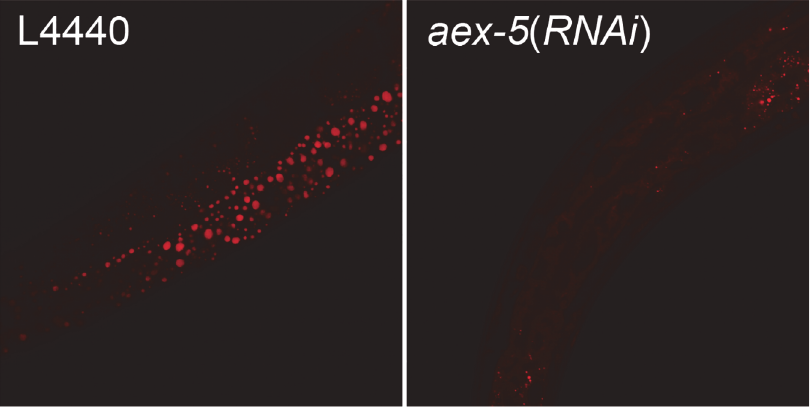
Fig 4. Fluorescence confocal micrographs of the intestines of young adult worms stained with Nile Red in isopropanol. The worms were subjected to RNAi by feeding after they had become adults. L4440 is the negative control in which wild-type adult worms were fed bacteria containing the plasmid vector L4440 alone. The aex-5 ( RNAi ) worms were fed bacteria expressing double-stranded RNA from part of the aex- 5